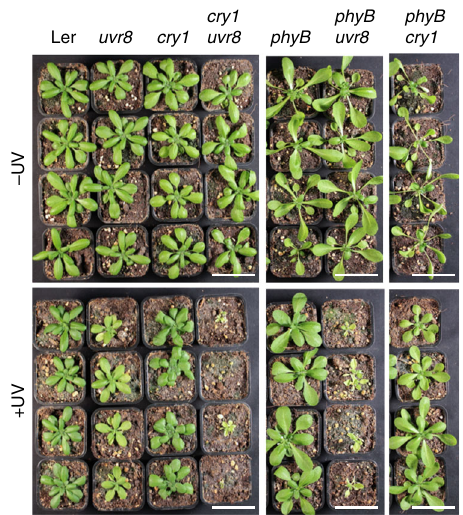
Fig. 5 Cryptochromes and phytochromes redundantly contribute to UVR8-mediated UV-B tolerance. Photographs of 28-d-old wild-type (Ler), uvr8-1 ( uvr8 ), hy4-2.23N ( cry1 ), hy4-2.23N uvr8-1 ( cry1 uvr8 ), phyB-5 ( phyB ), phyB-5 uvr8-1 ( phyB uvr8 ), and phyB-5 hy4-2.23N ( phyB cry1 ) plants grown under long-day conditions with 120 µ mol m − 2 s − 1 of white light with supplemental UV-B ( + UV, 0.07 mW cm − 2 ) or not ( − UV). Bars = 5